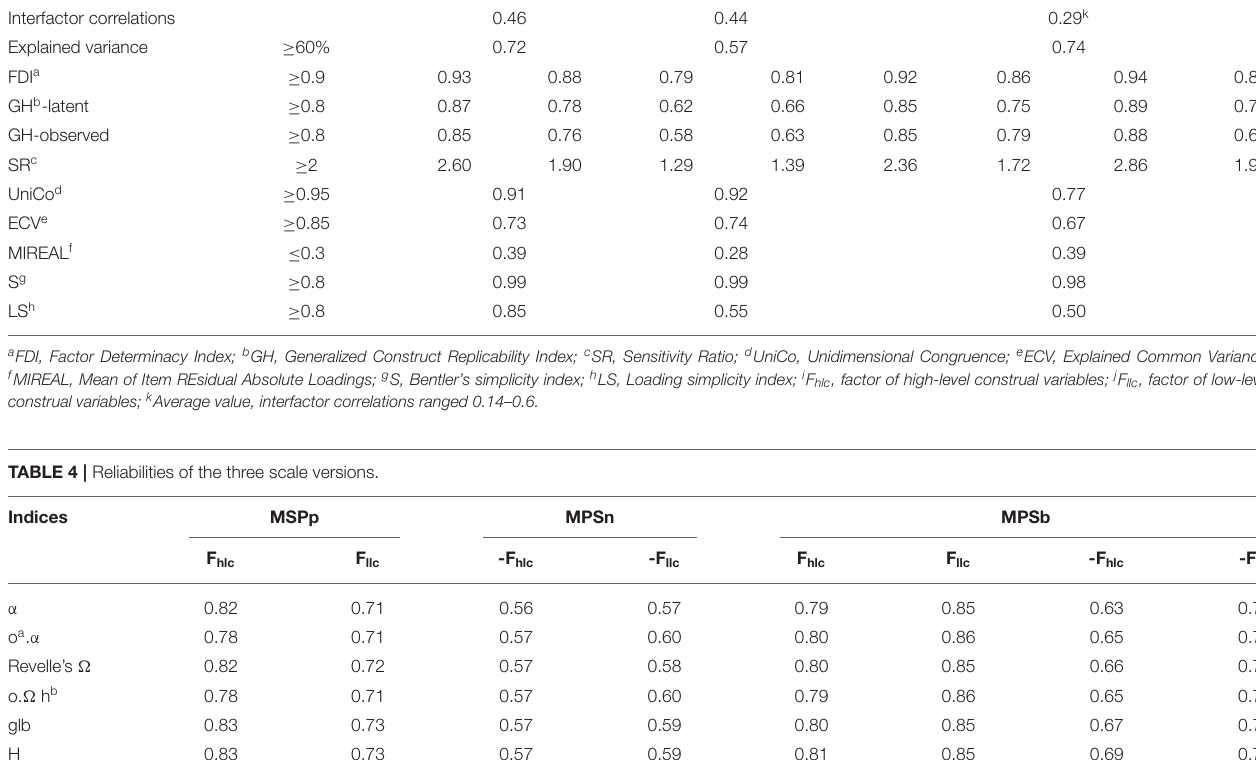
Interfactor correlations